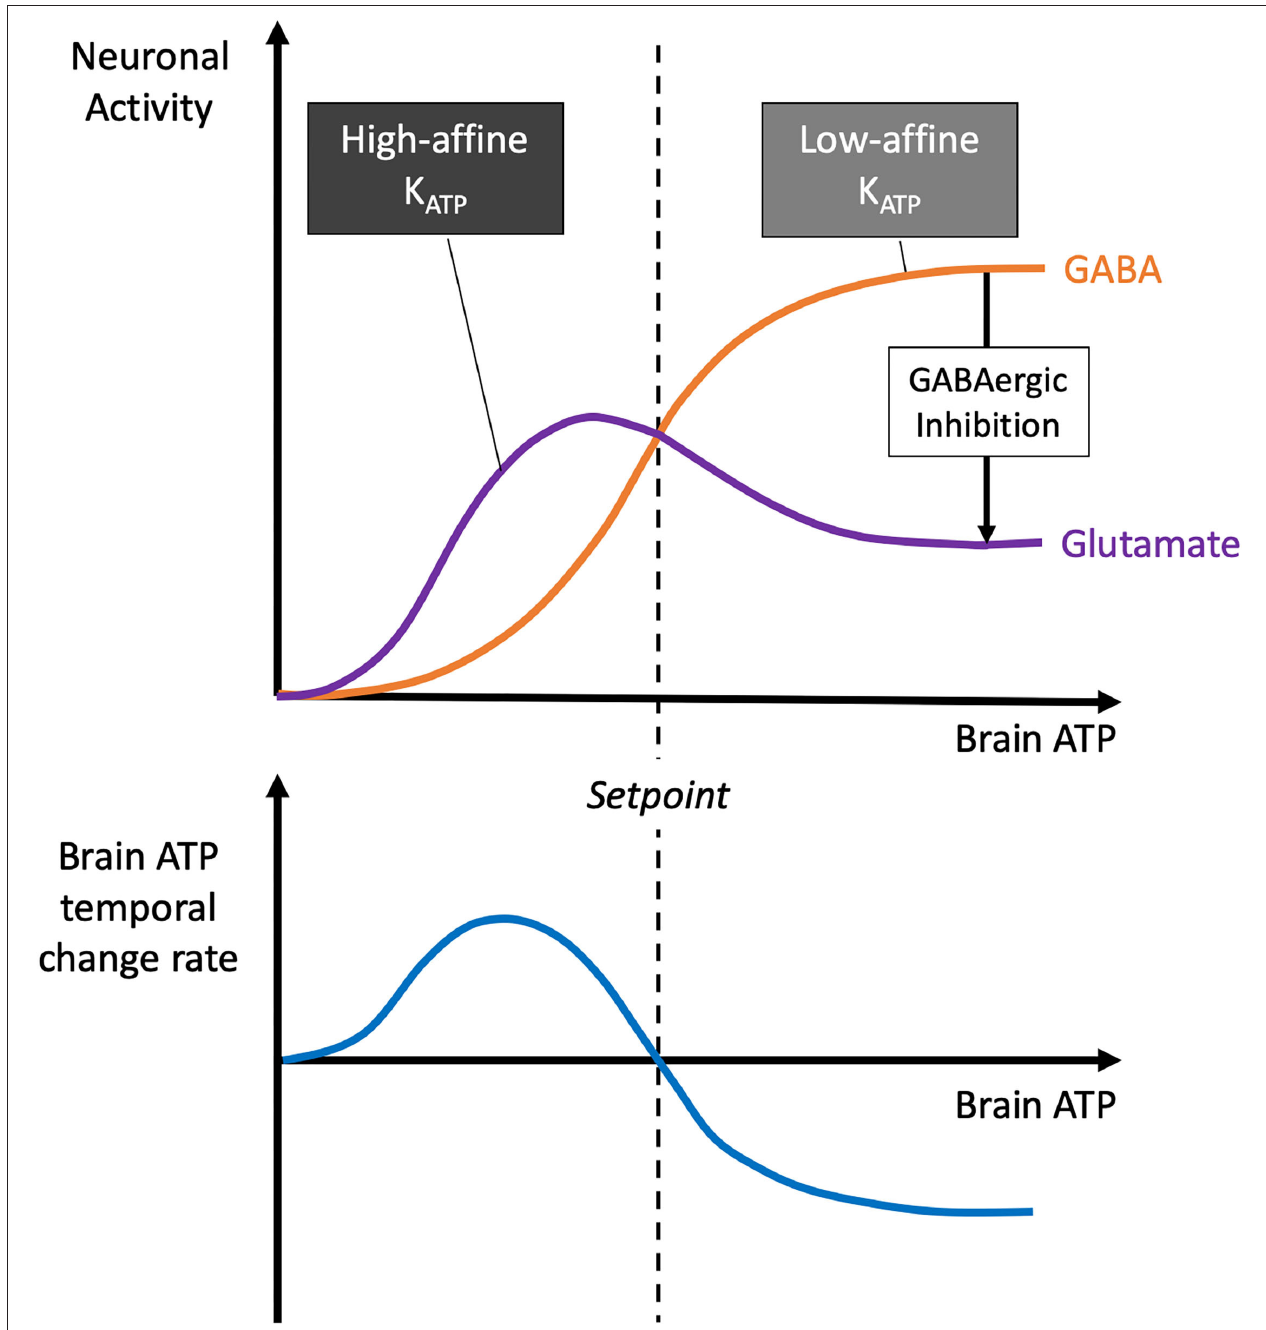
FIGURE 5 | Dependence of brain ATP temporal change rate, glutamatergic and GABAergic neuronal activity on brain ATP. The model shown here was formulated almost 20 years ago (Peters et al., 2004): As brain ATP decreases, presynaptic GABAergic neurons hyperpolarise first due to their low-affinity K ATP channels, followed by postsynaptic glutamatergic neurons with their high-affinity K ATP channels. Since glutamatergic neurons actively pull energy and GABAergic ones do not, a predominance of glutamatergic neurons in the low brain ATP range leads to positive brain ATP temporal change rates, while the predominance of GABAergic neurons in the high brain ATP range leads to negative rates. The brain ATP temporal change rate function dATP brain setpoint where brain energy homeostasis manifests itself. is consistent with the finding from our current systematic review that despite hyperglycaemia brain energy homeostasis can be